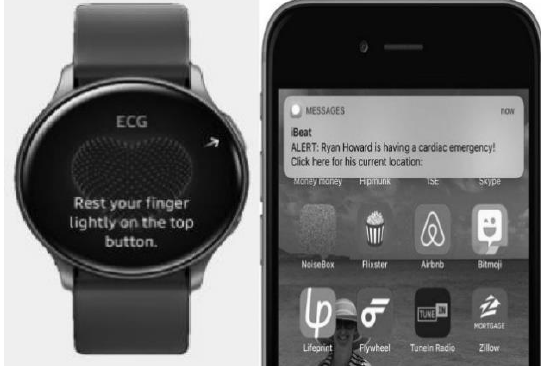
Figure 8. CODOC Patient family and doctor alert